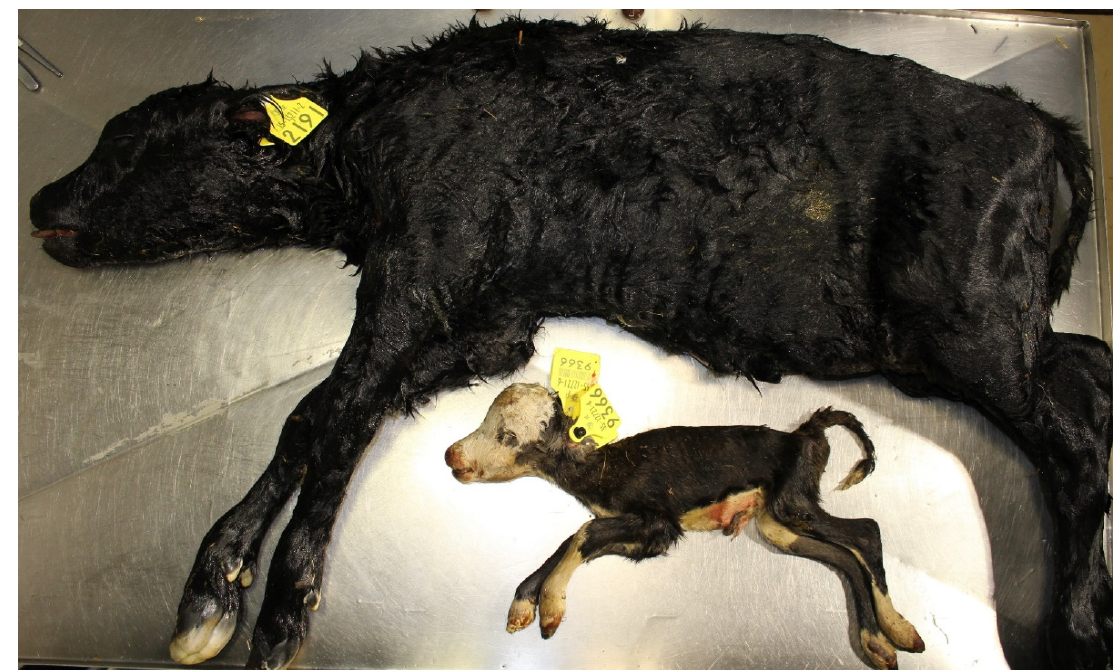
Figure 7. Aborted (2.4 kg, unknown gestation length) and stillborn (56.7 kg, 282 d gestation) foetuses.